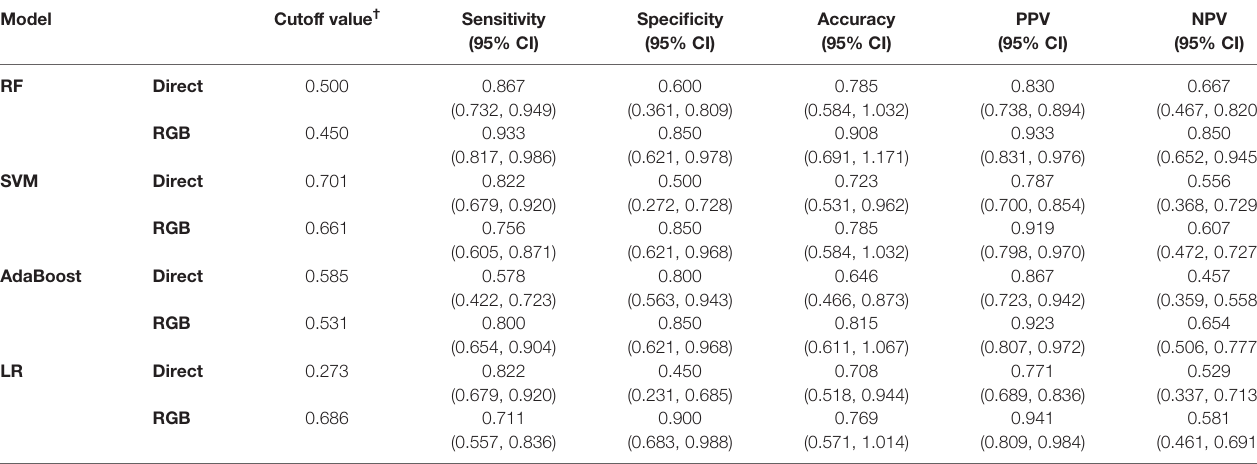
TABLE 2 | Diagnostic performance of direct model and RGB model among different classi fi ers in the validation cohort. Model